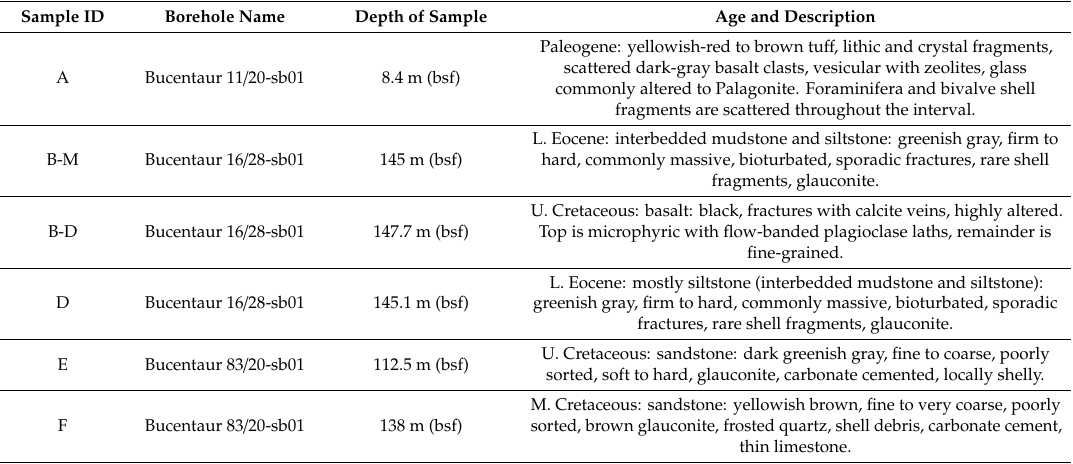
Table 1. Description of lithology where the six core plugs utilized in this study were retrieved from. The exact mineralogical composition of each core plug is found in the results